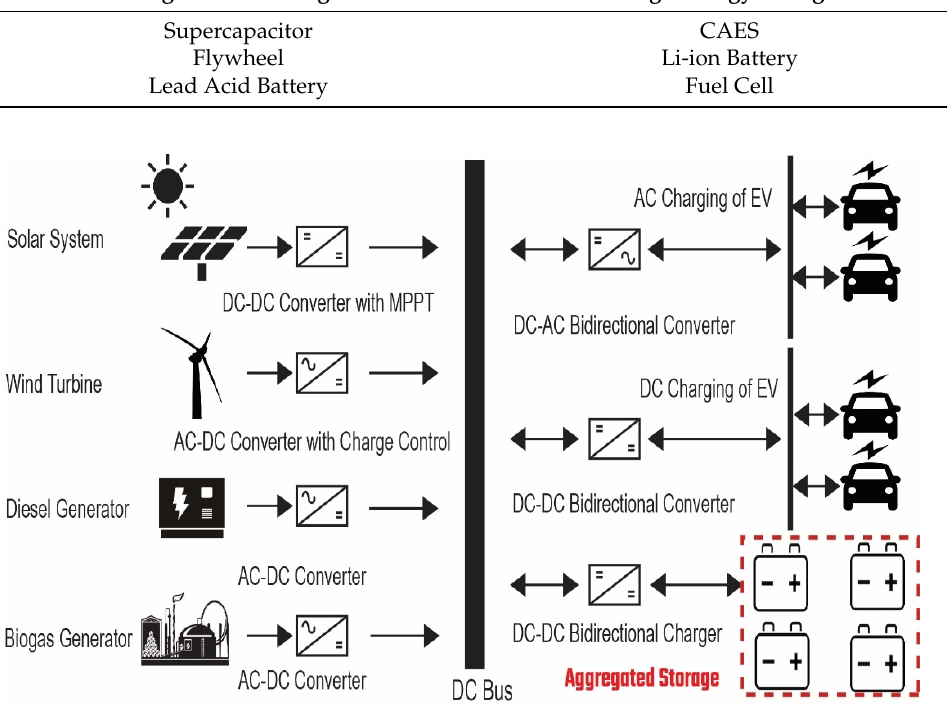
Figure 4. Standalone plugin electric vehicle charging station with hybrid energy storage.